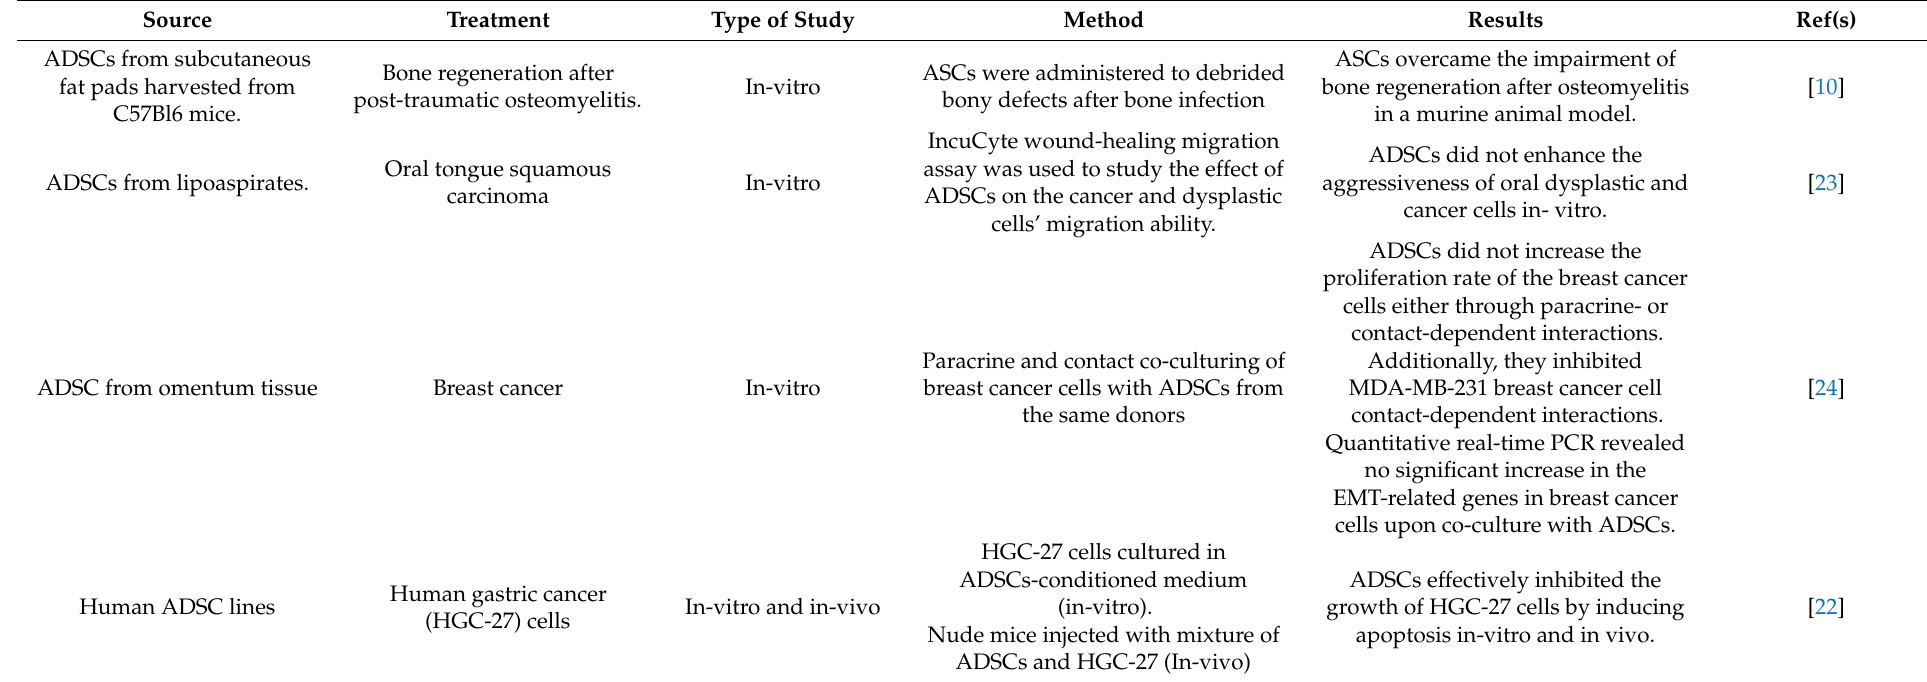
Table 1. The application of adipose-derived stem cells as a treatment for certain